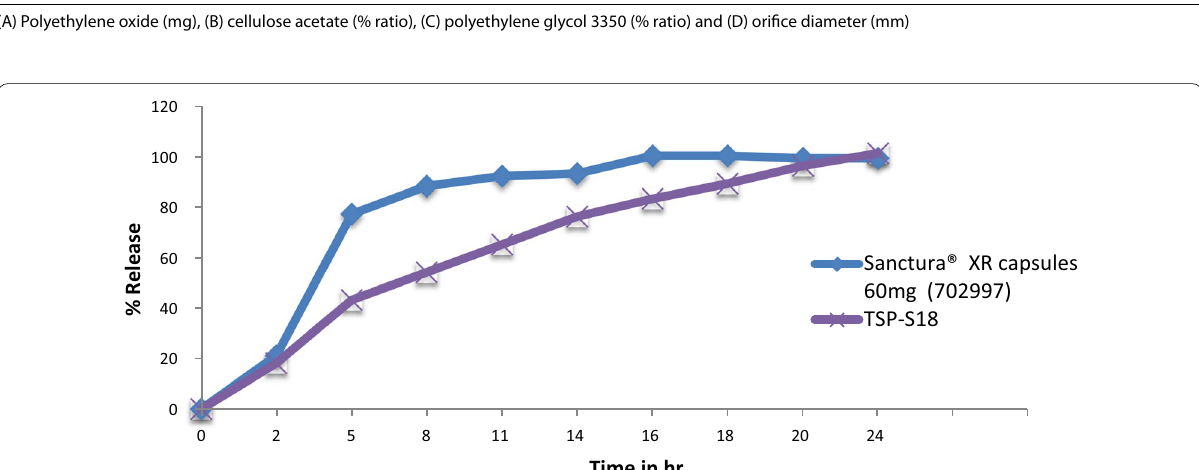
(A) Polyethylene oxide (mg), (B) cellulose acetate (% ratio), (C) polyethylene glycol 3350 (% ratio) and (D) orifice diameter (mm)